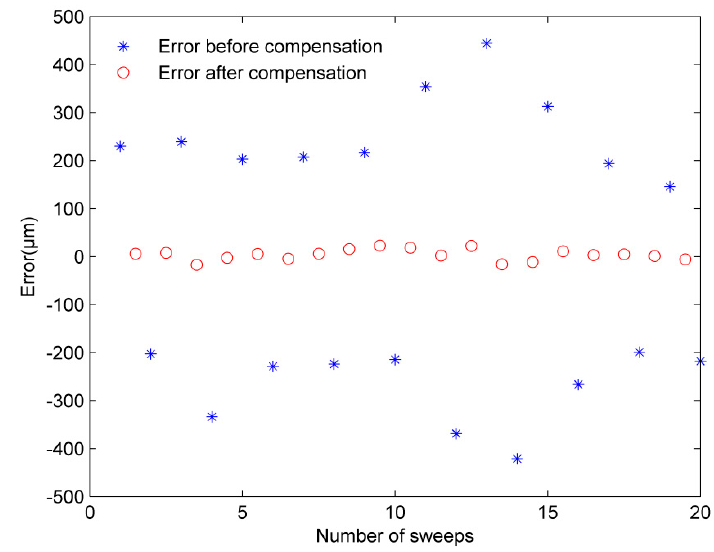
Figure 8. Distance error before and after the vibration compensation in a natural environment.